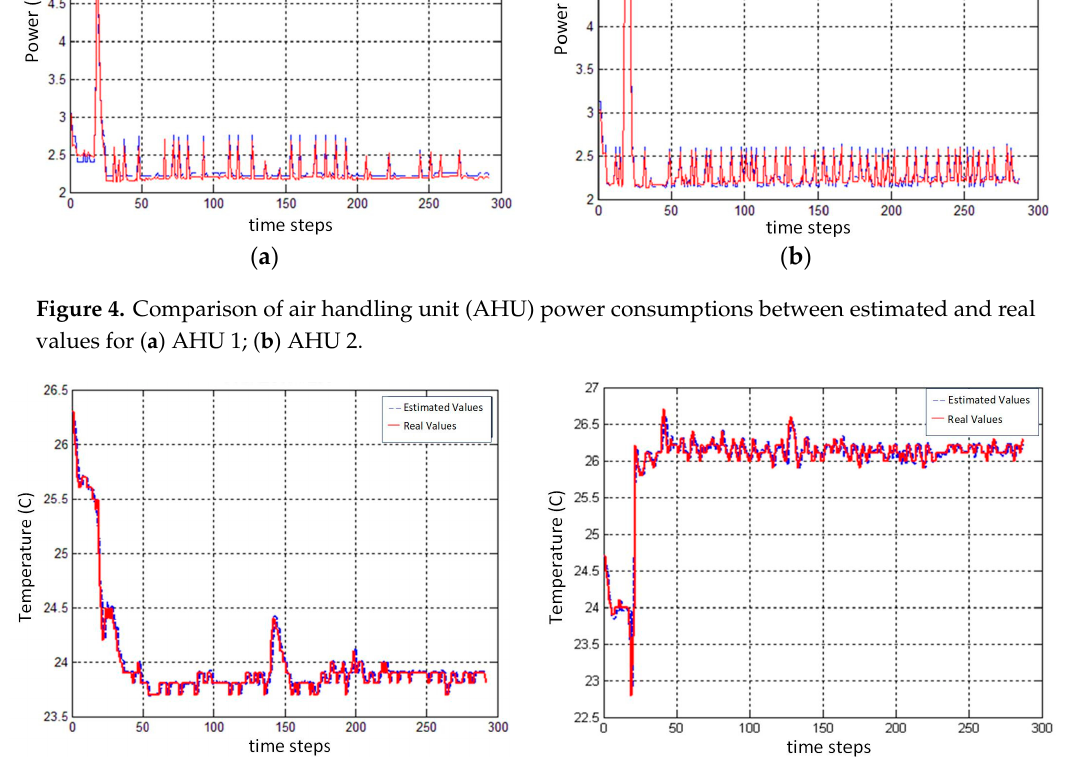
Figure 5. Comparison of predicted and real AHU outlet cold air temperature for ( a ) AHU 1; ( b ) AHU 2.